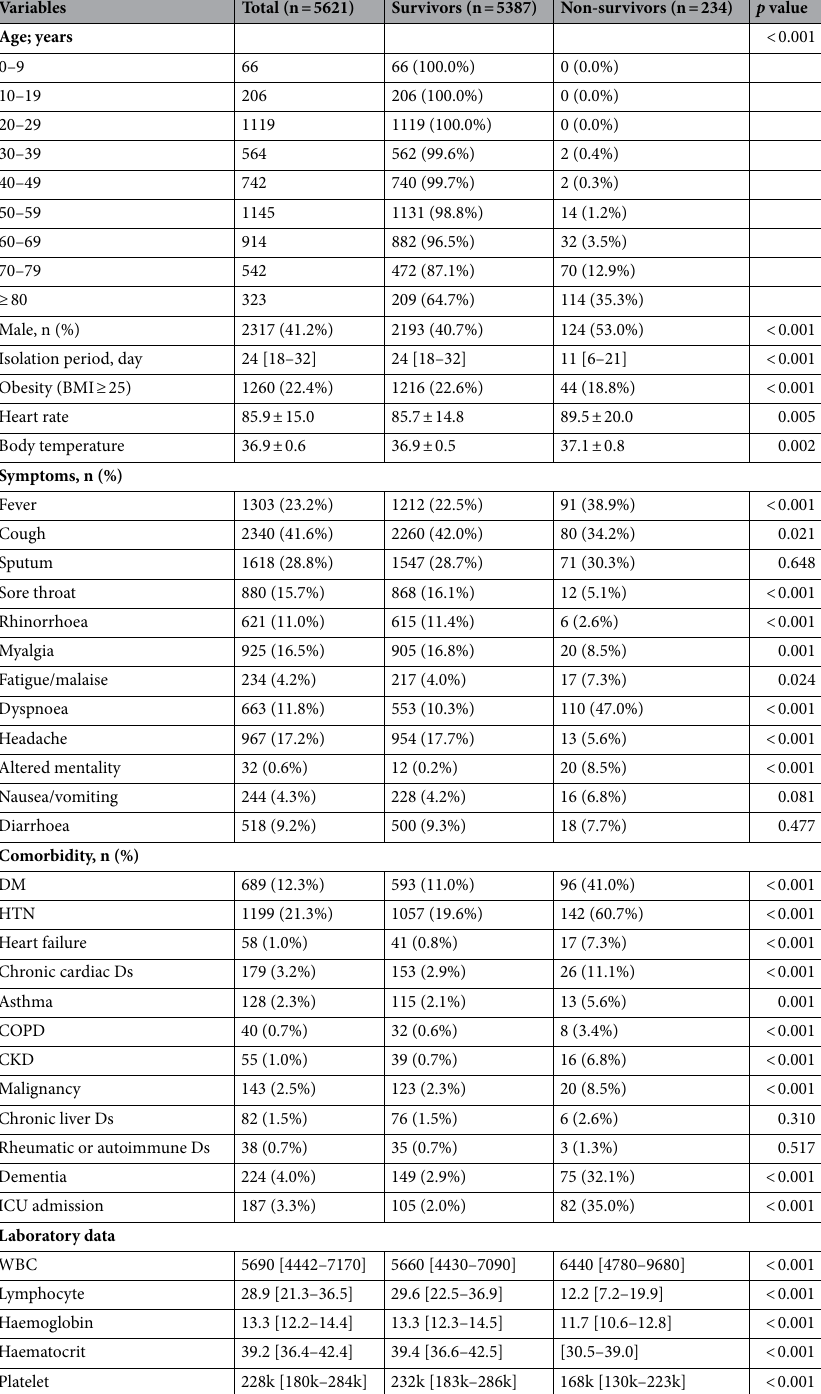
Table 1. Baseline characteristics of COVID-19 patients in Korea. COVID-19 coronavirus disease 2019, BMI body mass index, DM diabetes mellitus, HTN hypertension, Ds disease, COPD chronic obstructive pulmonary disease, CKD chronic kidney disease, ICU intensive care unit, WBC white blood